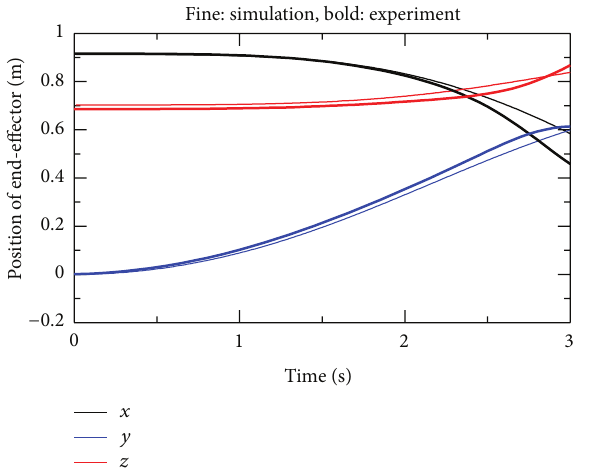
Figure 9: Verification of simulation model (2).